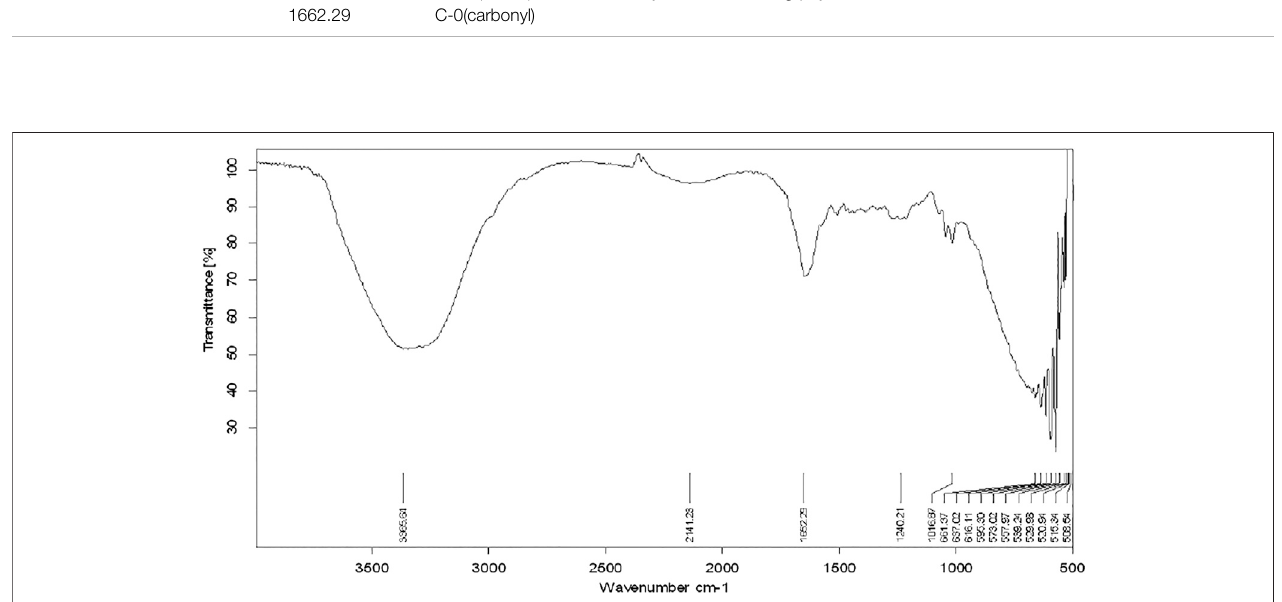
FIGURE 1 | FT-IR spectra of Achilleamillefolium